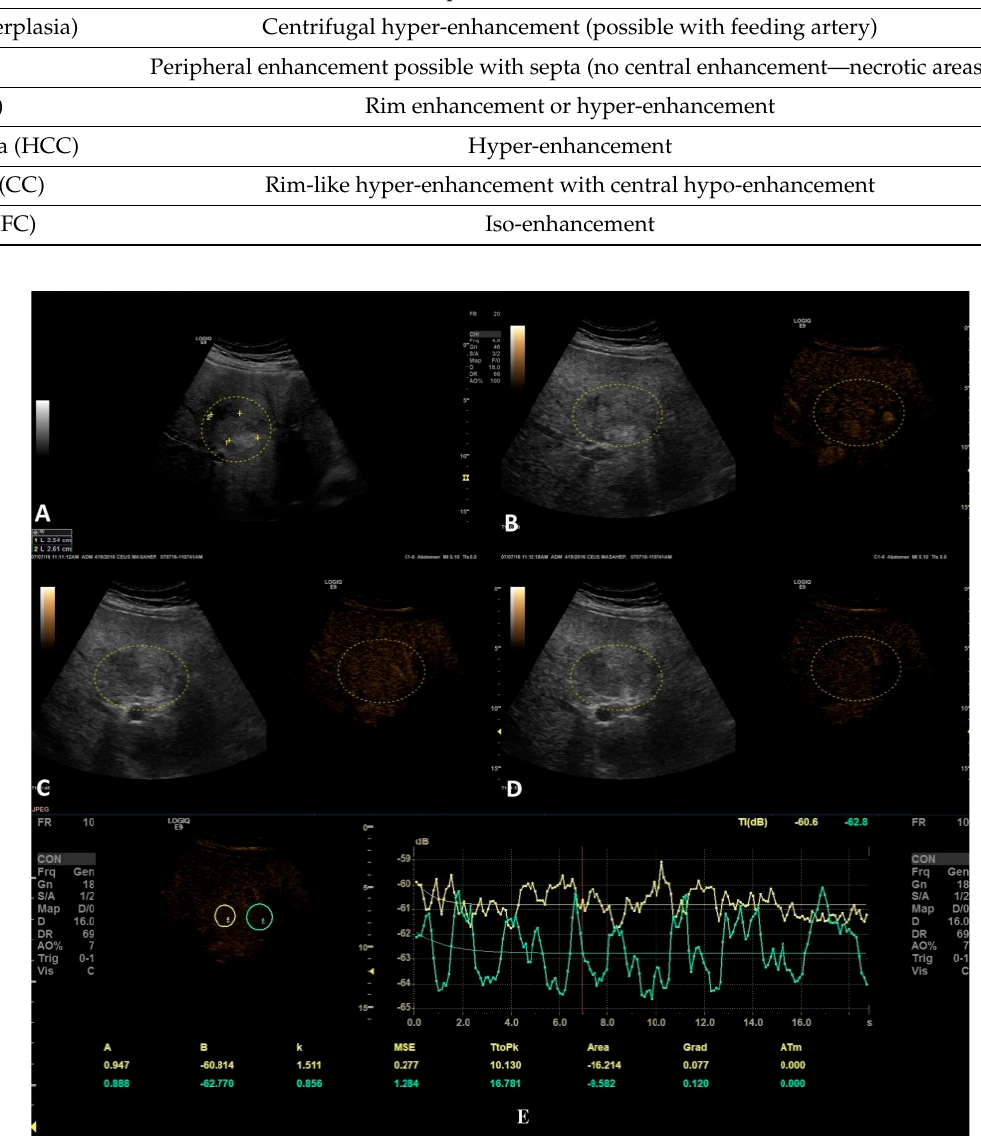
Figure 4. In this setting, a benign lesion was assessed, as depicted in B-mode in frame ( A ). In frames ( B – D ) are depicted the vascular arterial, portal, and late phases of CEUS with different enhancement characteristics, respectively. In frame ( D ), the enhancement pattern is not recognizable; thus, TIC analysis ( E ) was applied. The results did not show us any objective washout phenomena (the graphs are not intersecting one